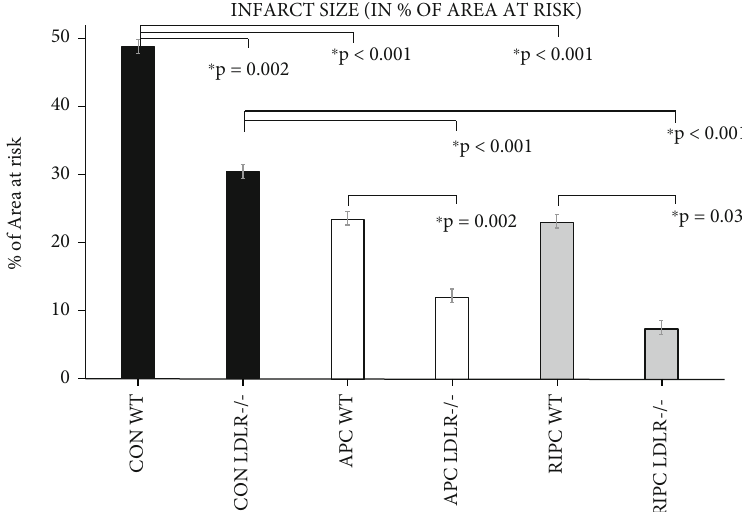
Figure 4: Infarct size: relative IS (IS/AAR) in CON, APC, and RIPC with and without LDLR-/- and high fat